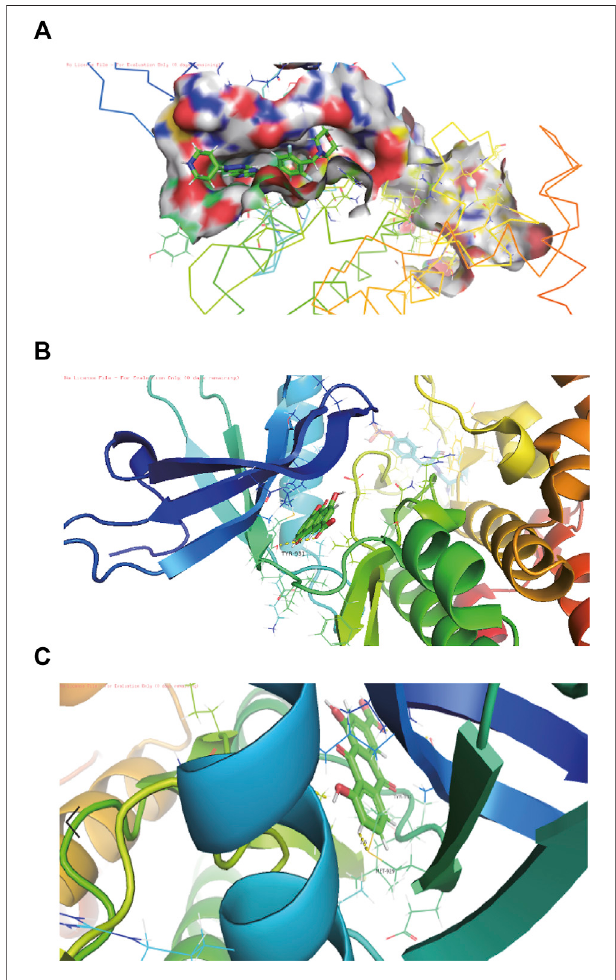
FIGURE 2 | The structure-activity relationships of rhein with JAK2 molecule. (A) Schematic diagram of the connection between jAk2 and 3kRR in the software pymol view, 3kRR is a compound structure that can already bind to JAK2. (B) Schematic diagram of docking with the pocket after rhein is replaced by 3KRR through molecular docking. (C) The residues in the pocket TYR-931 and MET-929 are the residues in the pocket, which they are stable binding sites for